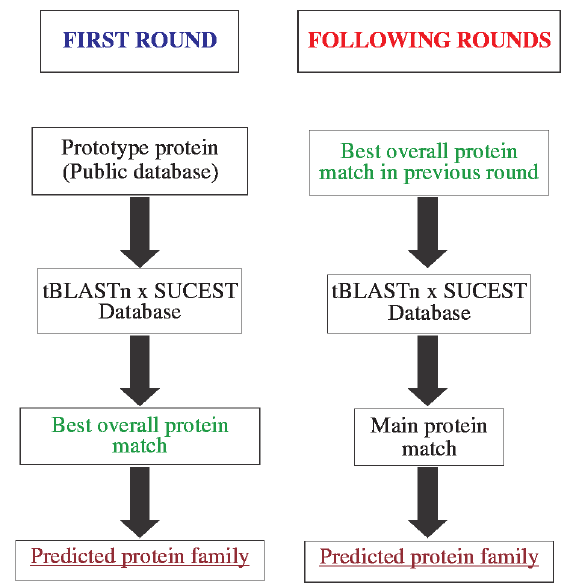
Figure 1 - General scheme for sequence mining and annotation strategy. Translated amino acid sequences of specifics mRNAs were chosen from chaperones and stress-related proteins deposited at public databases. The prototype sequences were compared with the first level cluster consensus generated from the sugarcane expressed sequence tag (SUCEST) database using the basic local alignment search tool tBLASTn program (Altschul et al. , 1997). The tBLASTn program was used to compare amino acid se- quences from public databases with nucleotide sequences generated from the SUCEST database and the SUCEST cluster sequence that had a signif- icant molecular chaperone match was considered to be a chaperone. To in- crease the accuracy of the prediction, the matches found in the first round of mining went through a second round (or more) of mining, allowing the location of better matches and/or new